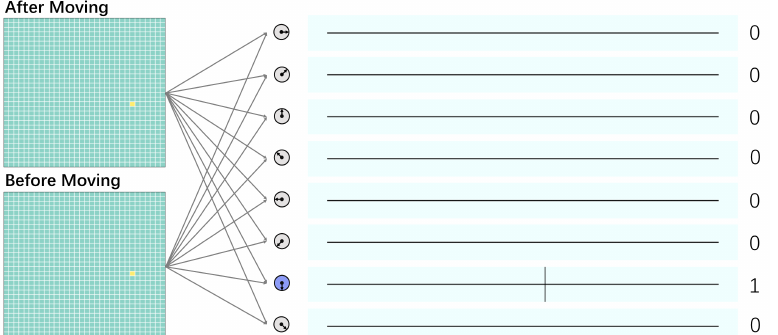
Figure 5. Computer simulation of machanism for detecting the moving direction of a one-pixel pattern being moved at − 1 unit along the y direction (a DOWNWARD movement) in two dimensions. (LEFT) images before and after moving, (RIGHT) responses of neurons recorded.